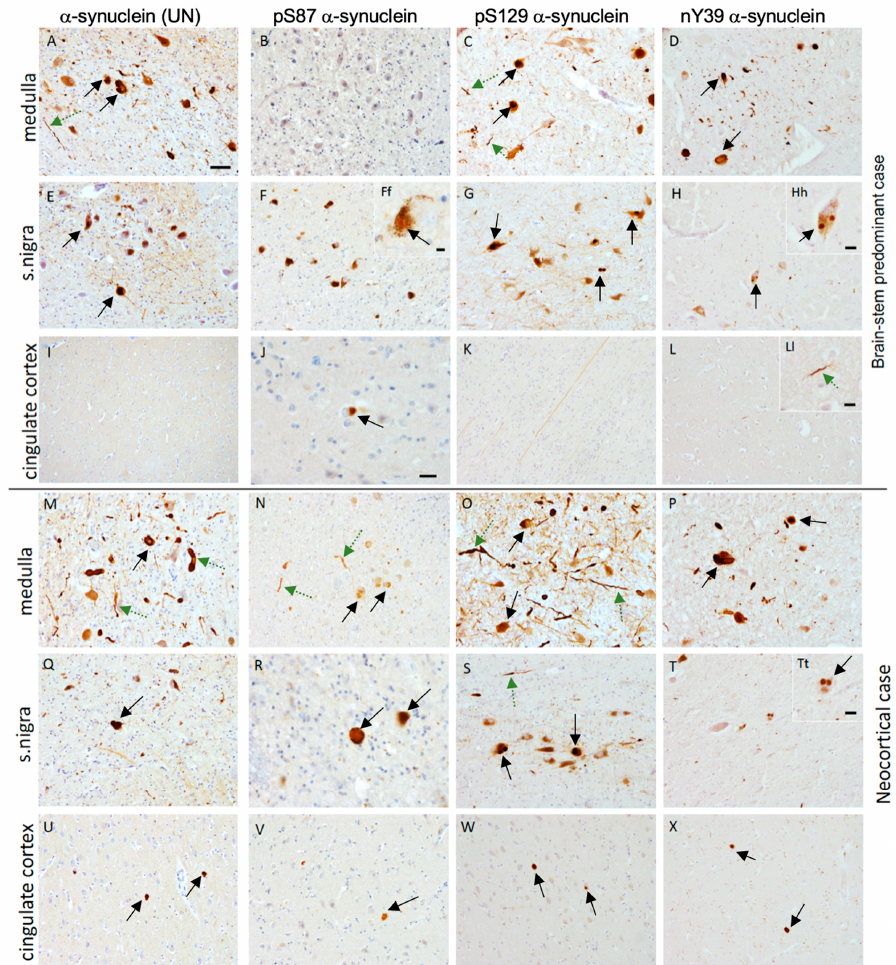
Figure 1. Illustration of immunostaining for different α -synuclein antibodies in IPD cases. ( A – L ) Regions from a brainstem-predominant PD case. ( A , E , I ) Immunostaining with α -synuclein (UN) showing LBs (black arrows) and LNs (green dashed arrows) in medulla and nigra but not in cingu- late cortex. Very few LBs or LNs were positive for pS87 α -synuclein, as shown in ( B , F , J ). Positive immunostaining of LBs and LNs in medulla and nigra but not in cingulate was observed with pS129 α -synuclein antibody. Some nonspecific staining of white matter tracts was observed ( K ). Immuno- positivity in LBs and LNs seen for nY39 α -synuclein antibody in the medulla ( D ) and nigra ( H , Hh ) and some LNs ( L , Ll ) in the cingulate cortex. ( M – X ) Regions from a neocortical PD case where higher numbers of LBs and LNs were immunopositive with all 4 antibodies. Scale bar: 20 μ m in all except in ( J ) where it is 10 μ m. Scale bar in insets ( Hh , Ll , Tt ) is 8 μ m.